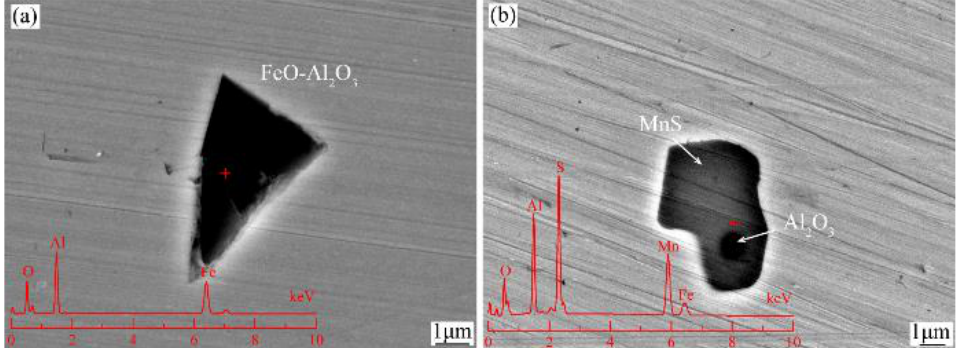
Figure 4. Compositions and morphologies of typical inclusions at LF start. ( a ) FeO-Al 2 O 3 inclusion, ( b ) MnS-coated Al 2 O 3 inclusion.